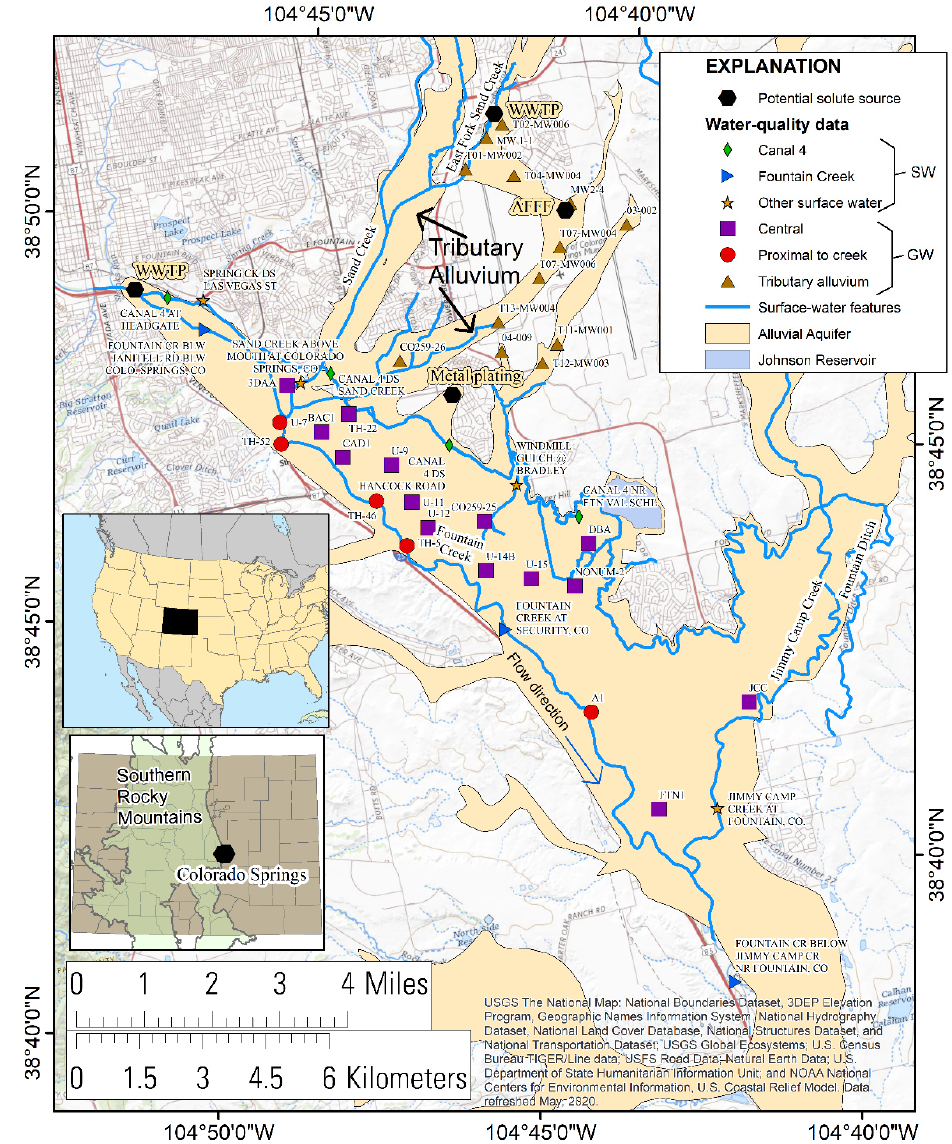
Figure 1. Map of study site with sampling locations, referenced according to the National Water Infor- mation System (NWIS) database [24], surface-water features, and extent of the alluvial aquifer [25,26]. Locations of potential solute sources are from References [27,28] and include wastewater treatment plants (WWTPs), areas of aqueous-film-forming foam (AFFF) use, and former metal-plating facilities. SW and GW refer to surface water and groundwater sample locations, respectively.